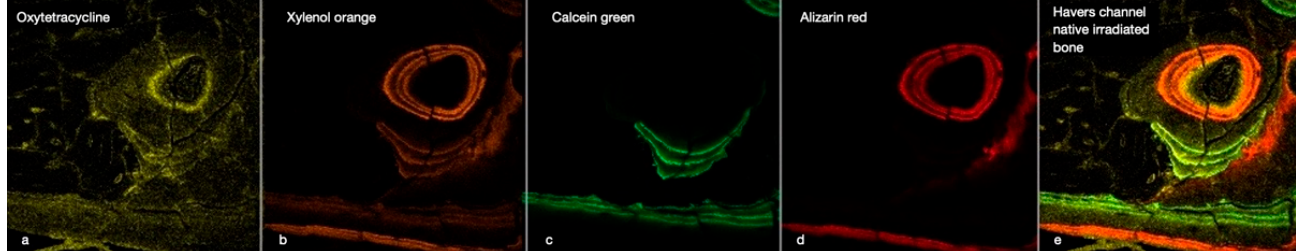
Figure 4. This image illustrates the chronology of the integration of the four fluorescent labels (OTC, XYL, CAL, and ALZ) into the cortical bone of an irradiated rabbit tibia ( a – d ). The image focuses on a Haversian canal containing a blood vessel surrounded by osteoblasts and osteocytes in their lacunae, with tubules connecting the cavities. Below are some periosteal bone attachments. The right window ( e ) gives an overall impression of bone activity over 8 weeks. (×40 magnification).